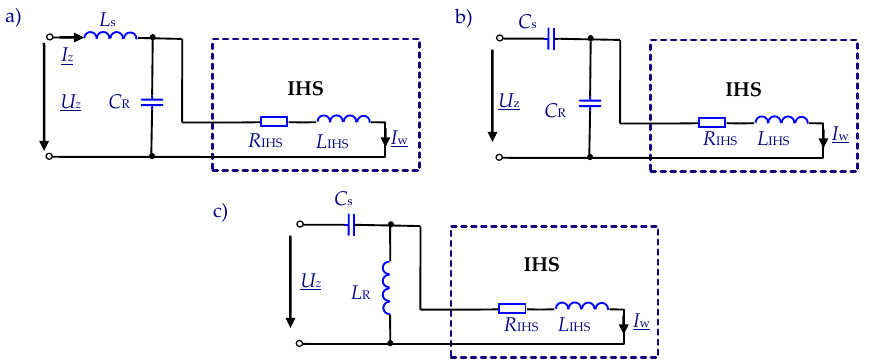
Figure 1. Third-order resonance systems: ( a ) LLC, ( b ) CLC, and ( c ) CLL.